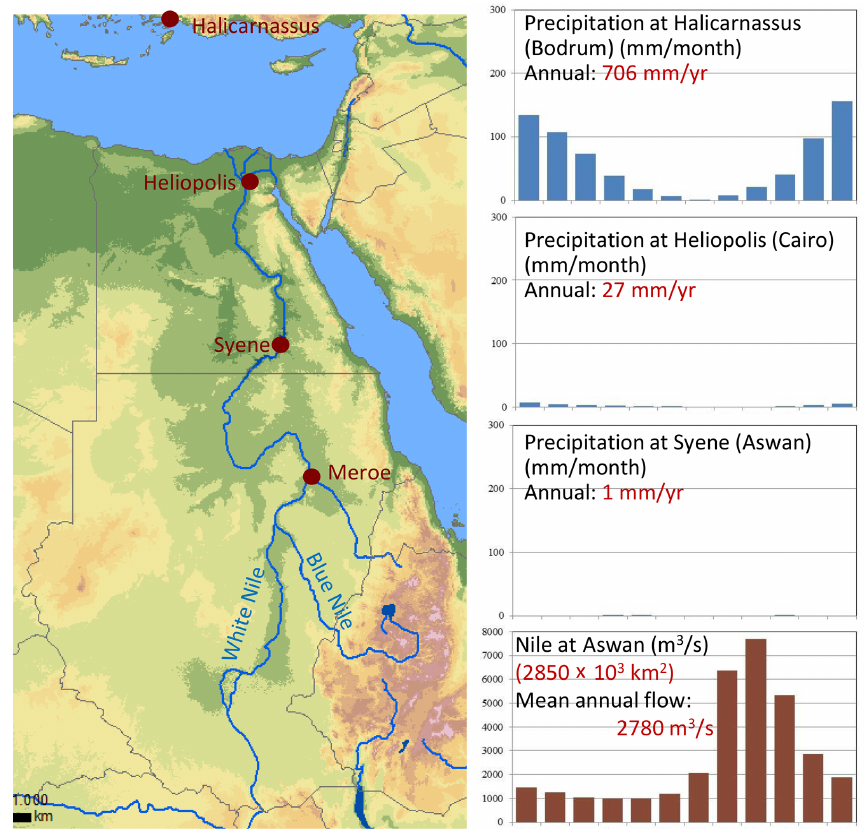
Figure 9. Map of the Nile area along with graphs of mean monthly precipitation (from modern measurements; months January to December) at characteristic ancient sites and mean monthly flow at Aswan